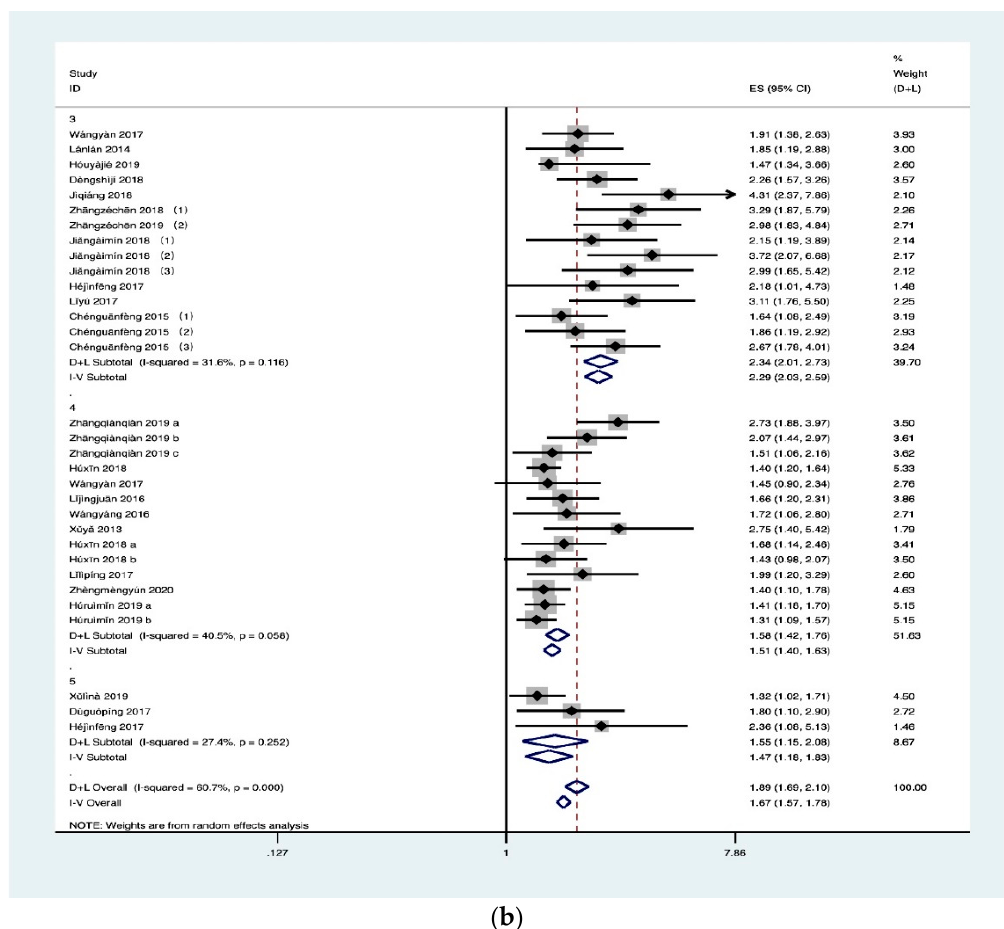
Figure 2. ( a ) Meta for IC. 1: gender; 2: locations. ( b ) Meta for IC. 3: grade; 4: academic performance; 5: race; (1): Sophomore year; (2): Junior year; (3): Senior year; a: excellent academic performance; b: good academic performance; c: average academic performance .